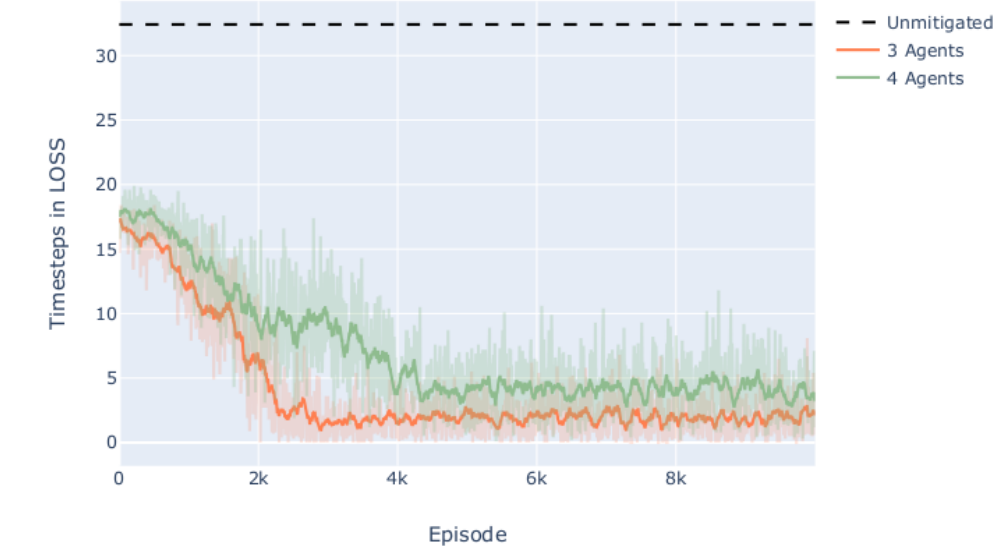
Figure 3. Number of time steps spent in